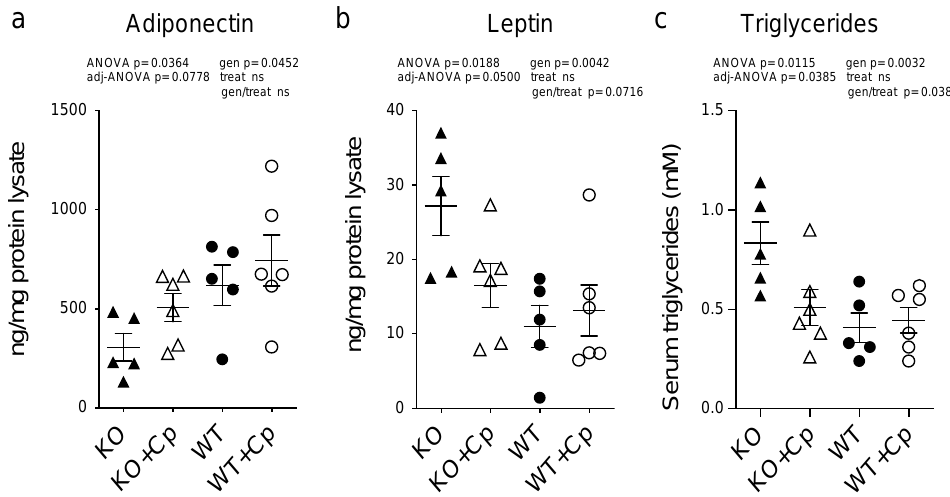
Figure 7. CpKO mice show altered adipokines profile in the adipose tissue and increased circulating triglycerides that are partially restored by Cp administration. ( a ) Adiponectin and ( b ) Leptin concentrations measured by ELISA in pgAT extracts from 10 months-old mice after 2 months of treatment with intraperitoneal injection of Cp 5 μg/g , administered every 5 days (KO+Cp; WT+Cp) or saline (KO, WT). ( c ) Triglycerides concentration in the serum from mice of different groups measured by Enzyme Chrome triglyceride assay kit. Data: mean ± SEM of animal groups, each dot corresponds to one animal (CpKO, WT n = 5; CpKO+Cp, WT+Cp, n = 6). Statistical p values were evaluated by two-ways ANOVA and reported as value for overall ANOVA, value for Benjamini-Hochberg adjustment for multiple ANOVA tests related to adipose tissue features (adj-ANOVA), for genotype variable (gen), for treatment variable (treat) and for the interaction of genotype/treatment